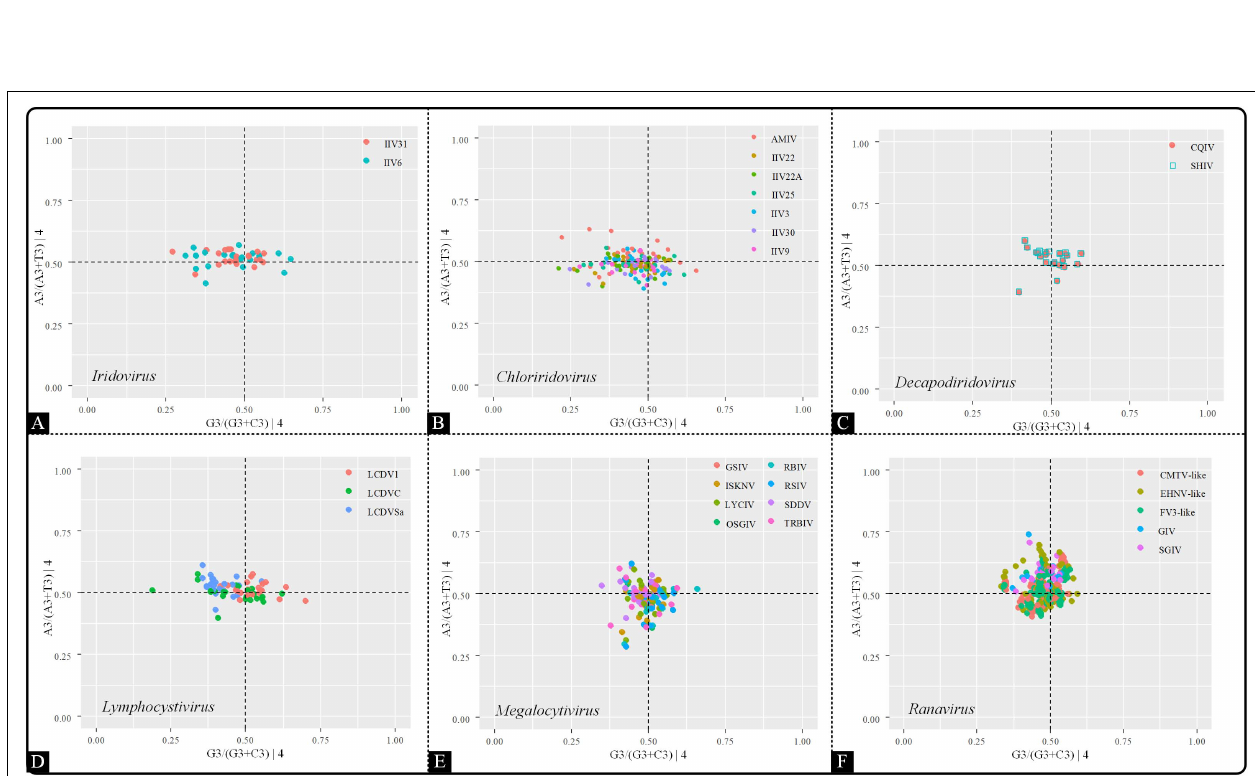
FIGURE 7 | PR2 plot analysis of the viruses within the indicated genera. The positions of the points were based on the AT and GC bias in the third codon position. (A) Iridovirus , (B) Chloriridovirus , (C) Decapodiridovirus , (D) Lymphocystivirus , (E) Megalocytivirus , and (F) Ranavirus.